Question: What style of plot is this figure drawn as?
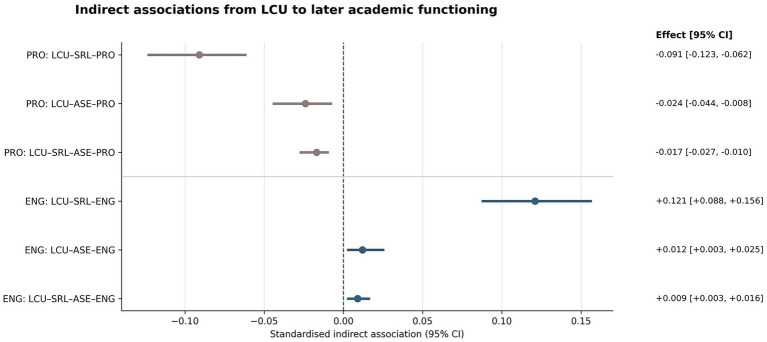
Answer: bar